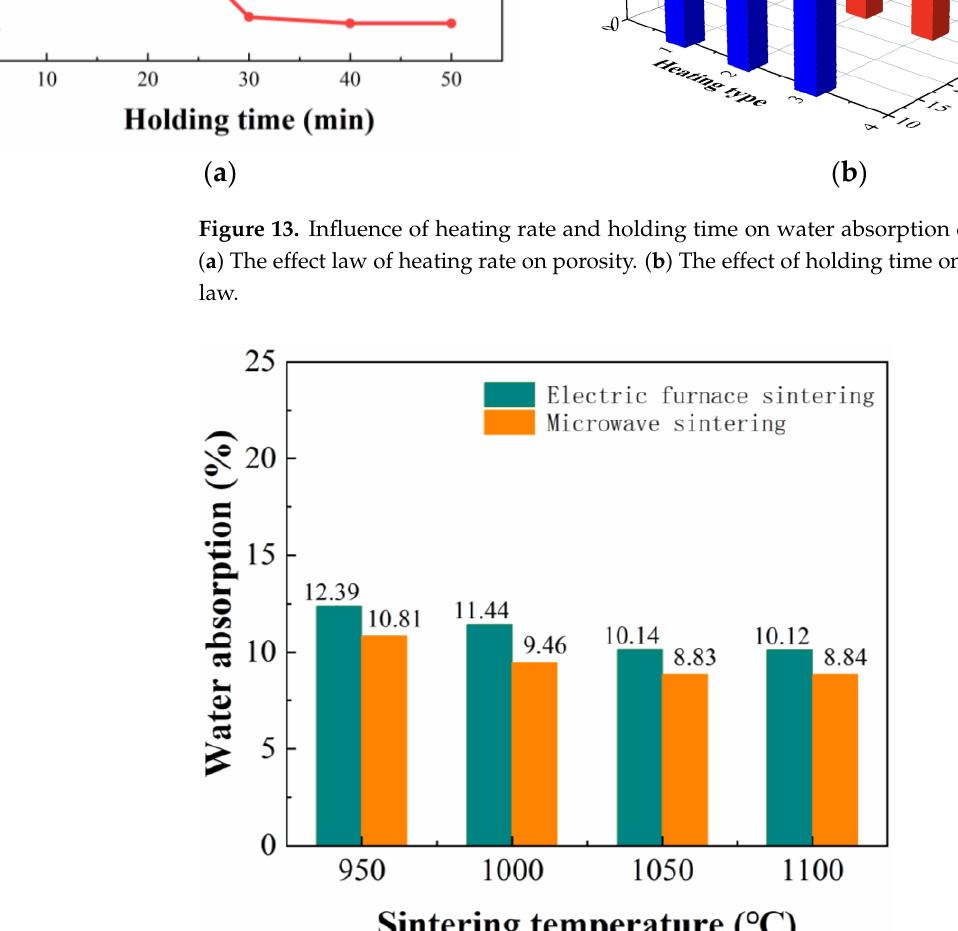
Figure 14. Effect of sintering temperature on water absorption of sintered bricks due to different sintering methods.